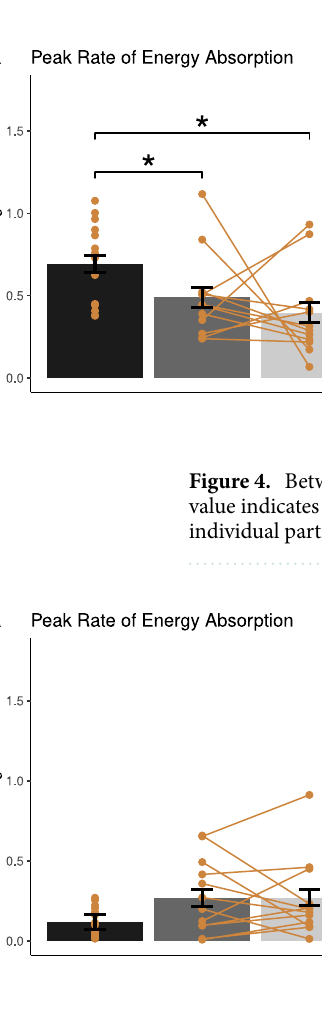
Figure 5. Between-group comparison of knee joint kinetics and kinematics (mean ± standard error). Negative value indicates knee flexion in torque ( B ) and angular velocity ( C ). Yellow points show data from individual participants, and data from the same participant are linked with yellow lines. *p < 0.05, **p <